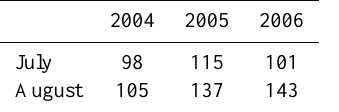
Figure 26. Monthly mean atmospheric concentration of particulate matter lower than 10 µ m (PM10) measured along the Sahelian Dust Transect (M'Bour, Senegal, 14.25°N/16.96°W; Cinzana, Mali, 13.28°N/5.93°W and Banizoumbou, Niger, 13.31°N/2.66°E) in 2006 (see their location on Fig.1). (the monthly means have been computed from the raw daily mean concentrations available on the AMMA data base using on wind direction criterions to select only dust transport wind sectors).